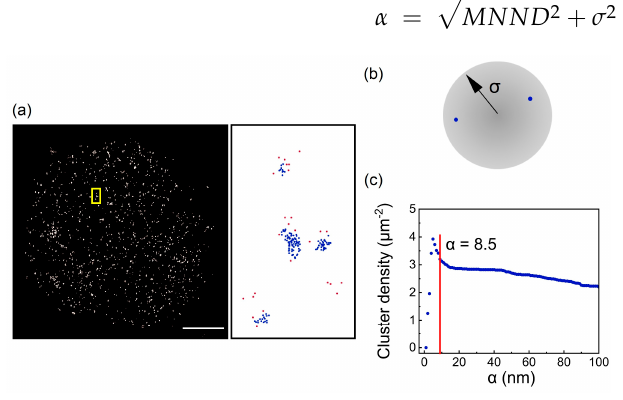
Figure 2. Adaptive determination of the segmentation threshold in FACAM. ( a ) A reconstructed super-resolution image of CD138. The dotted image is from the enlarged image of the rectangular region (yellow). Moreover, blue dots represent core localizations in the dotted image. Scale bar: 4 µm. ( b ) Single molecule localization with localization precision ( σ ). ( c ) The dependence of clustering density and segmentation threshold. Here the segmentation threshold ( α = 8.5 nm) was calculated by FACAM.